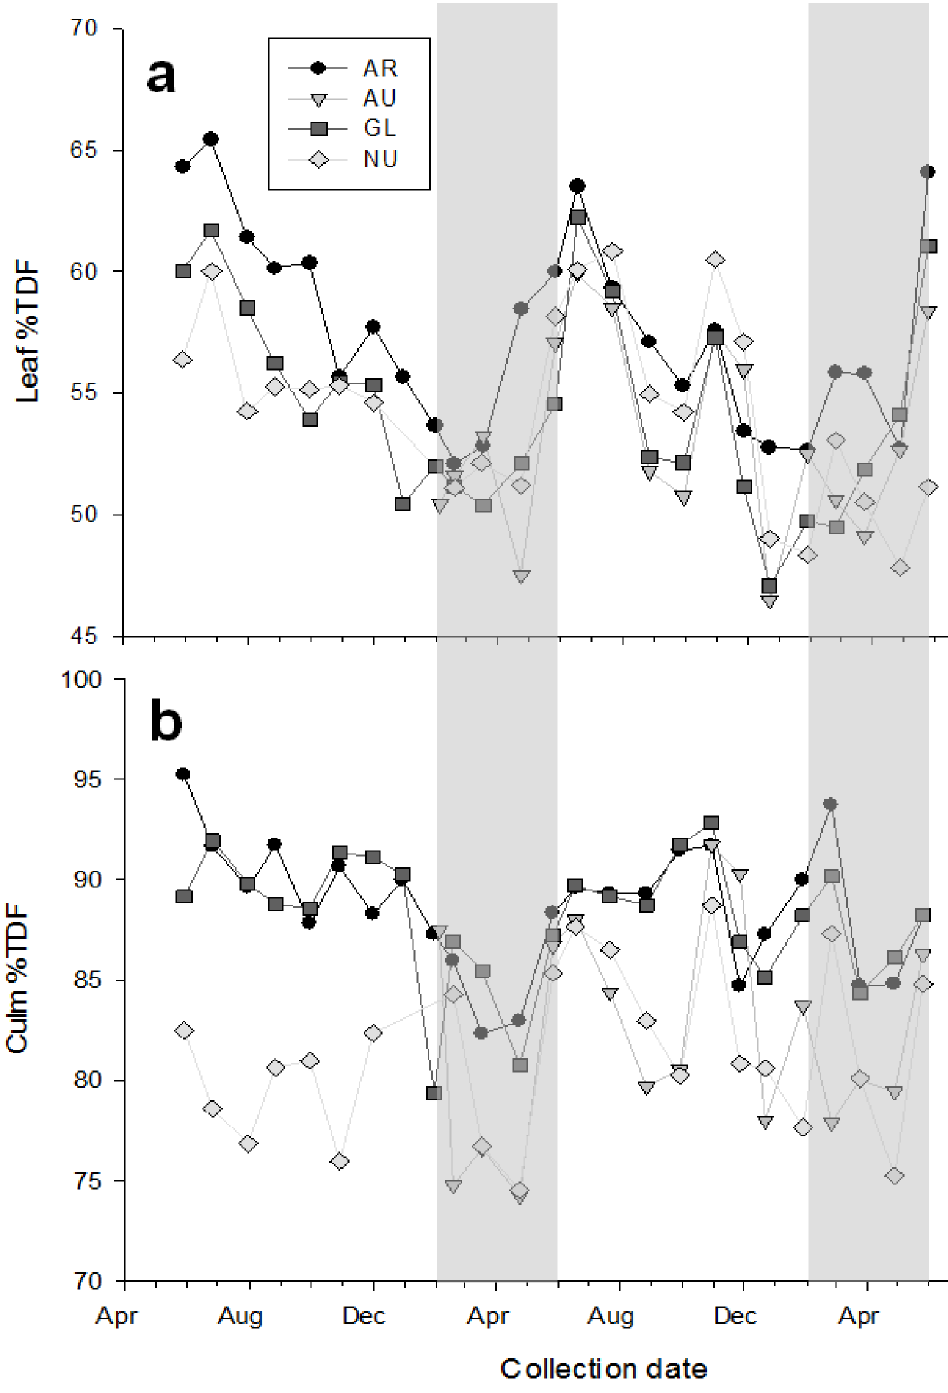
Fig 1. Fiber content in bamboo leavesand culm. Total dietary fiber (TDF) concentrations for (panela) leaf and (panelb) culm of bamboospecies Phyllostachys ( P .) aurea (AR), P . aureosulcata (AU), P . glauca (GL), and P . nuda (NU). Samples were collectedmonthly over a periodof 18–27 mo. Data are expressedas a percentage of dry matter (DM). The shadedarea represents the time when captive giant pandas consumed primarily